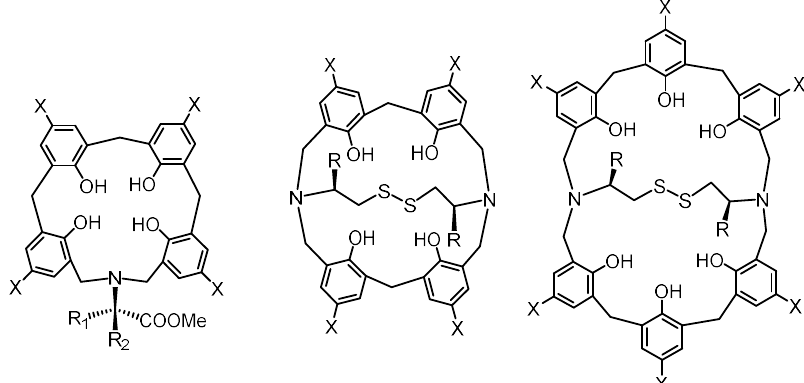
Figure 3. Amino-acid-bridged